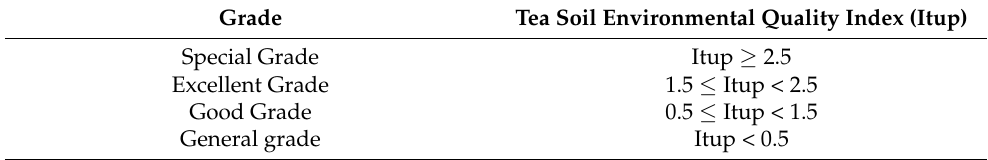
Table 3. Grading of tea climate taste evaluation.